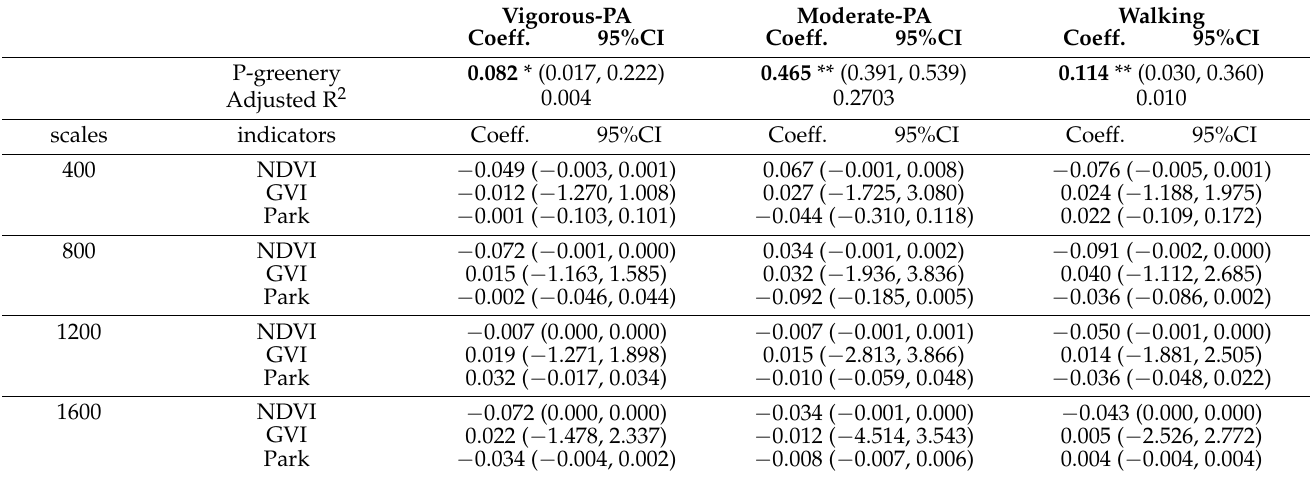
Table A2. The association between green space and physical activity at different spatial scales. Vigorous-PA